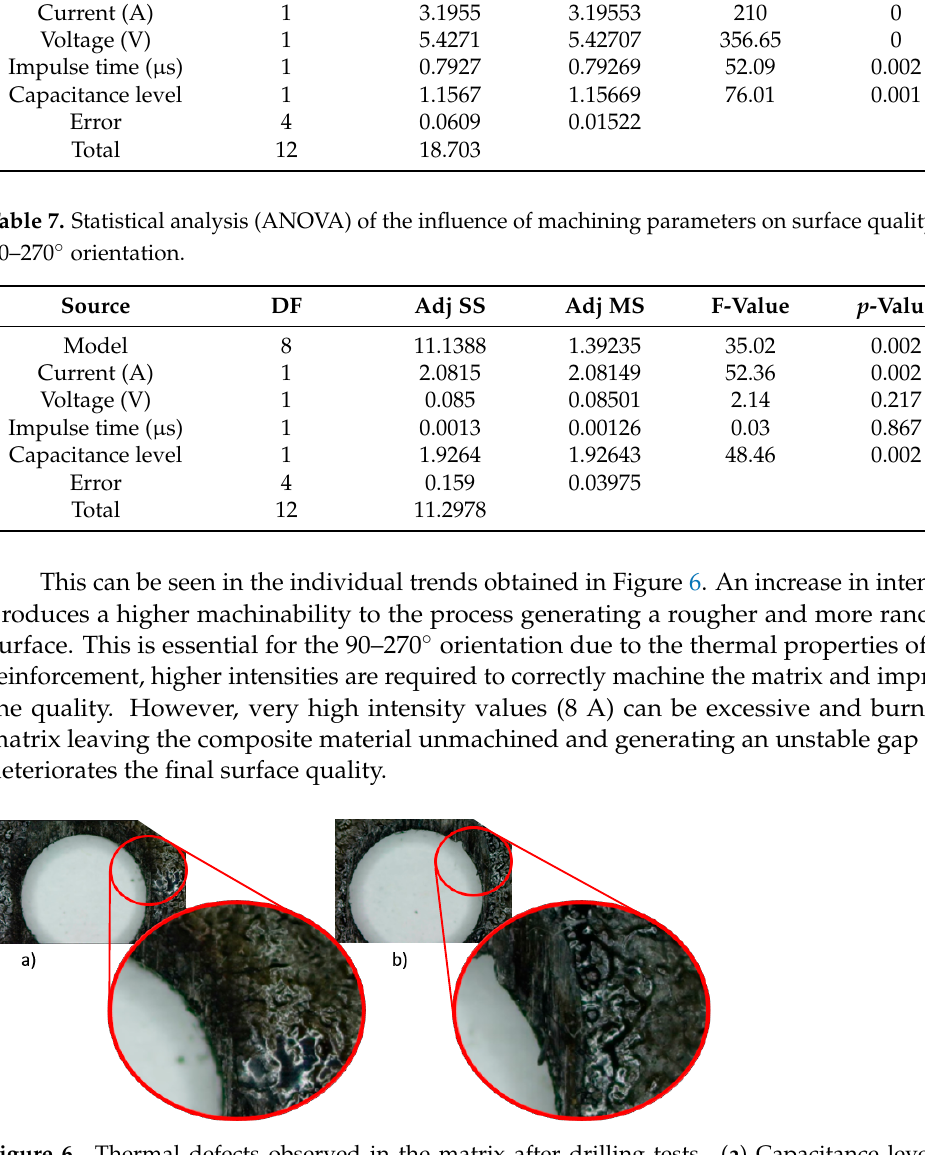
Figure 6. Thermal defects observed in the matrix after drilling tests. ( a ) Capacitance level 25. ( b ) Capacitance level 35.